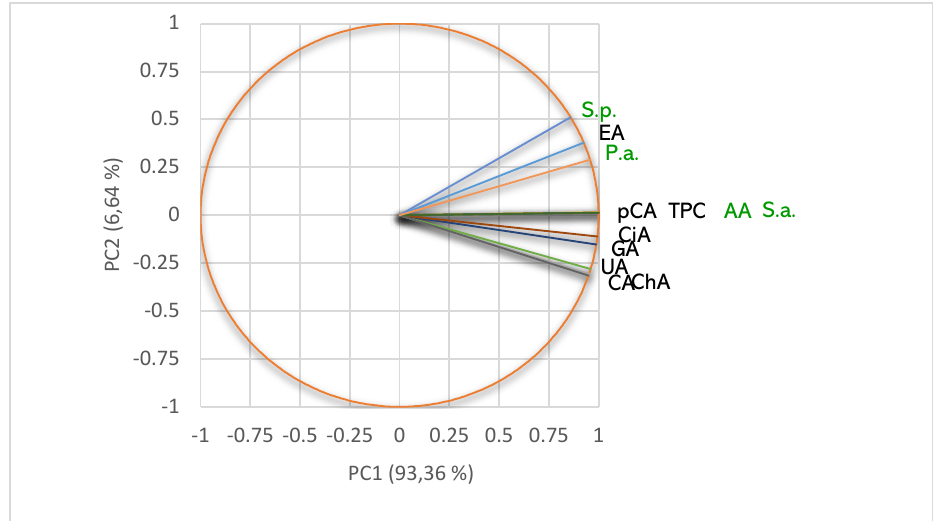
Figure 7. PCA-Correlation circle between TPC, UA, and individual polyphenols in m UBE and antibacterial and antiradical activities. m UBE— U. barbata liquid ethanol extract, pCA— p -coumaric acid,